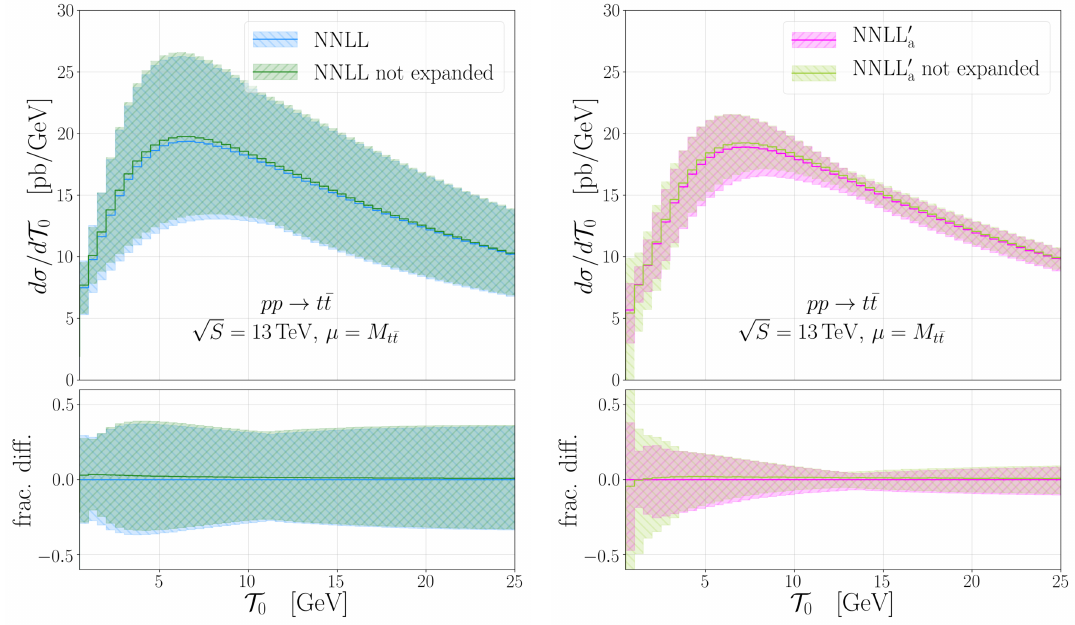
Figure 4 . Resummed T 0 distribution with and without the expansion of U in eq. (3.2), at both NNLL (left) and NNLL 0 accuracy a